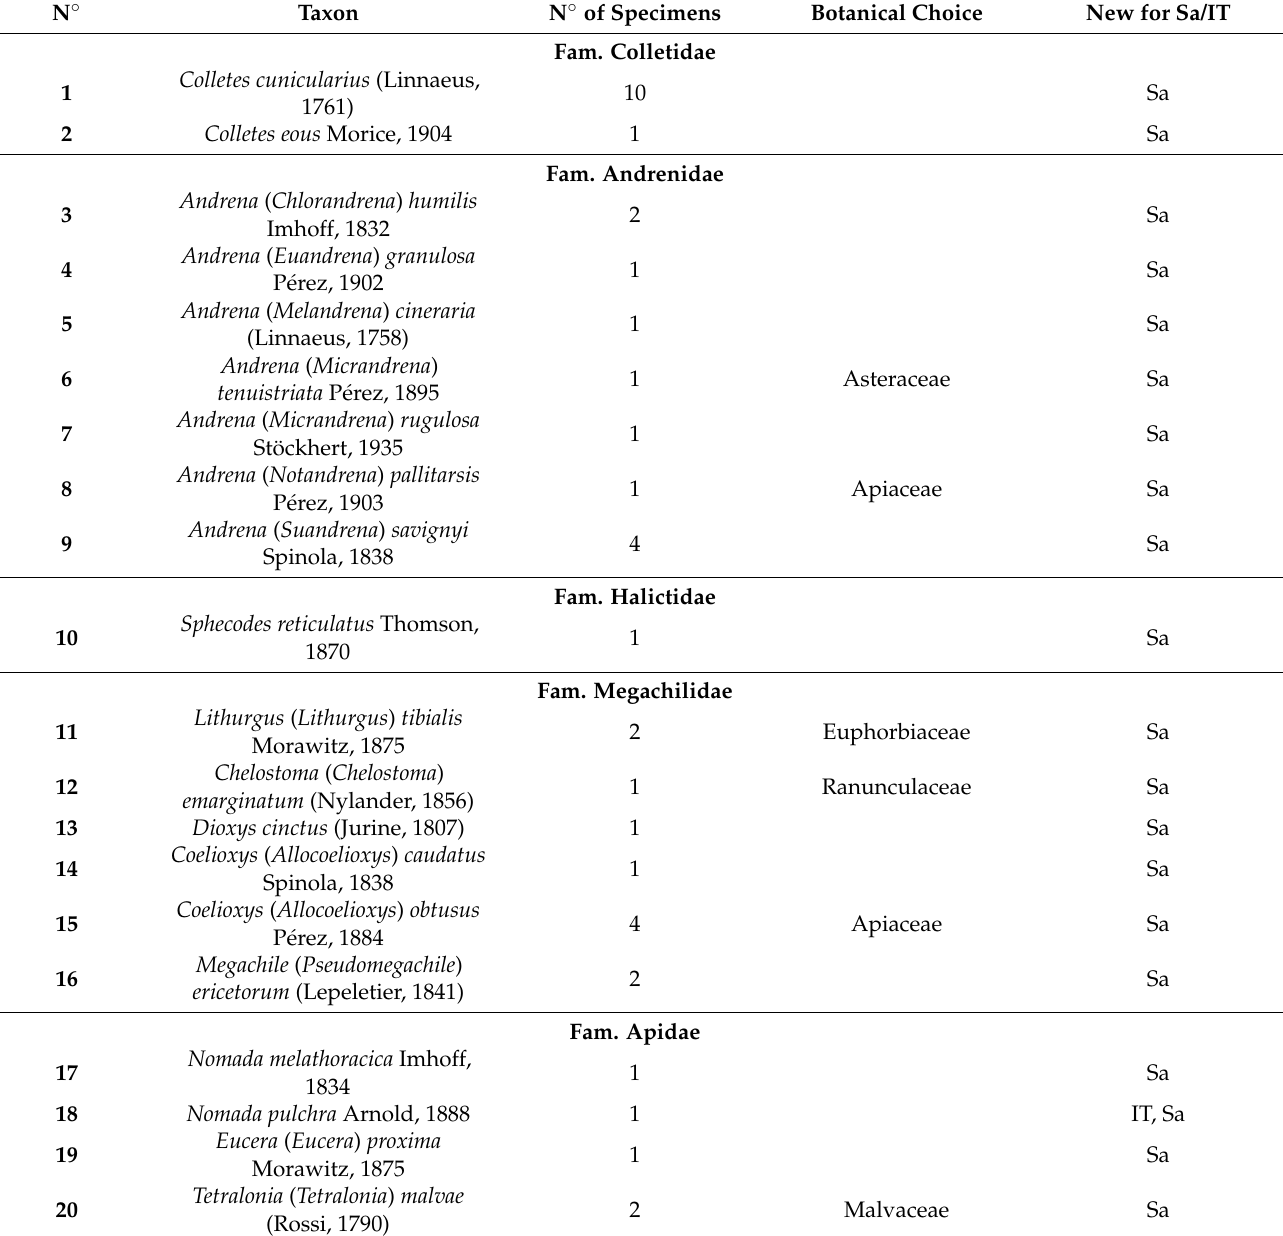
Table 1. List of recorded species of Apoidea that were new for Sardinia (Sa) and, in one case, for Italy